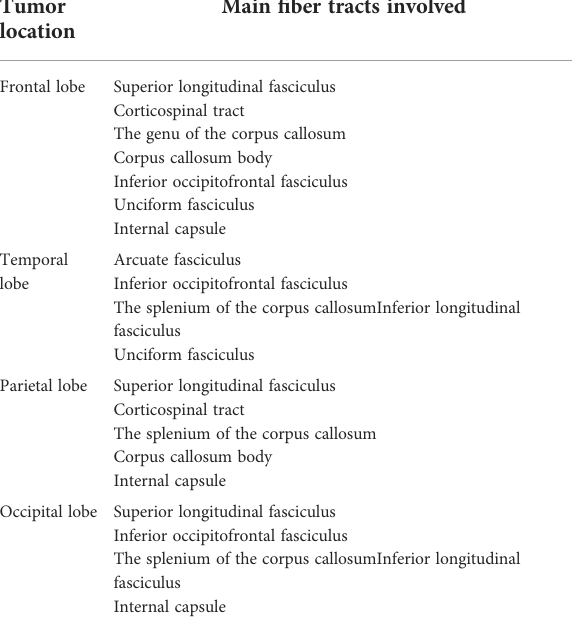
TABLE 1 List of main fi ber tracts involved in different tumor